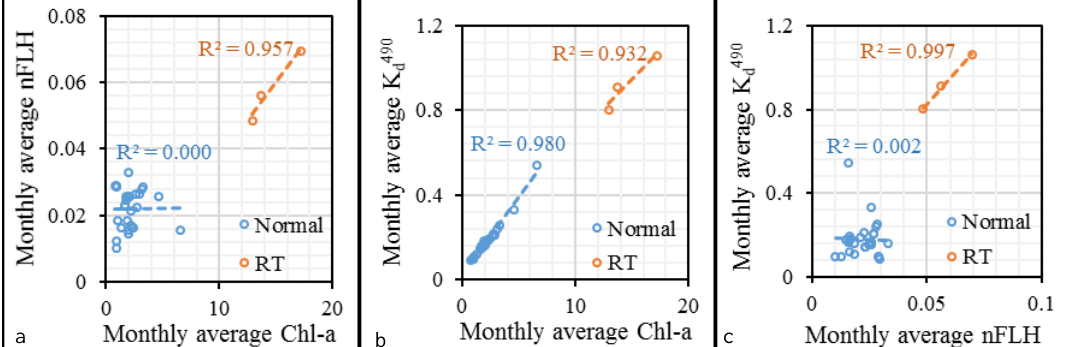
Figure 5. Scatter plots of Chl-a, K d490 , and nFLH vs each other during the normal and RT periods. The units of Chl-a, K d490 , and nFLH are mg.m -3 , m -1 , and mW.cm -2 .µm -1 .sr -1 , respectively. Dashed lines represent trend lines and R 2 is coefficient of determination.